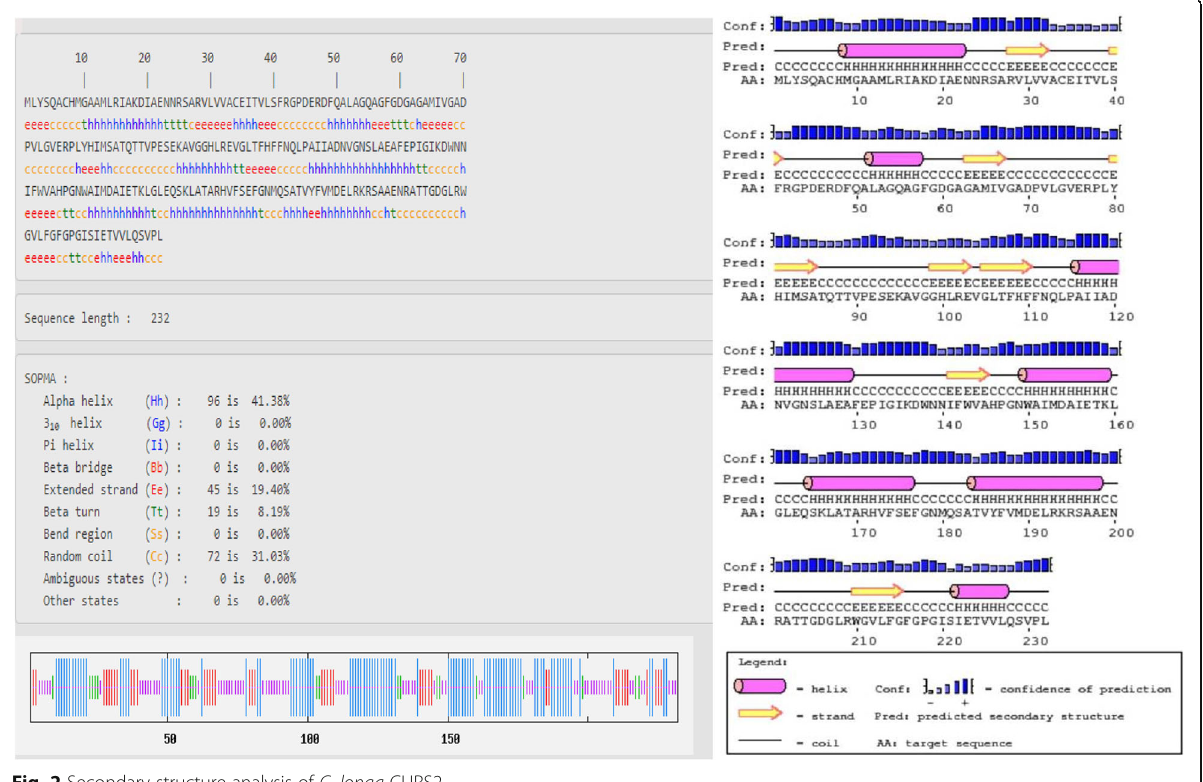
Fig. 2 Secondary structure analysis of C. longa CURS2